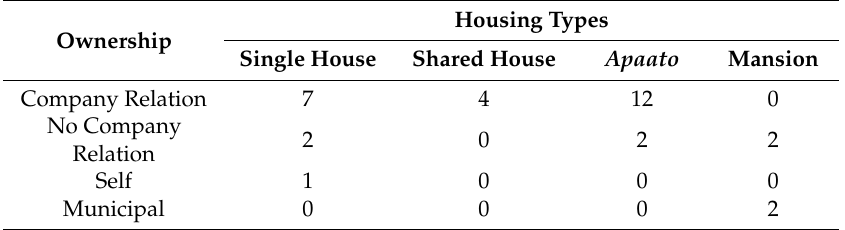
Table 1. Housing types and ownerships in which the participants (by households)